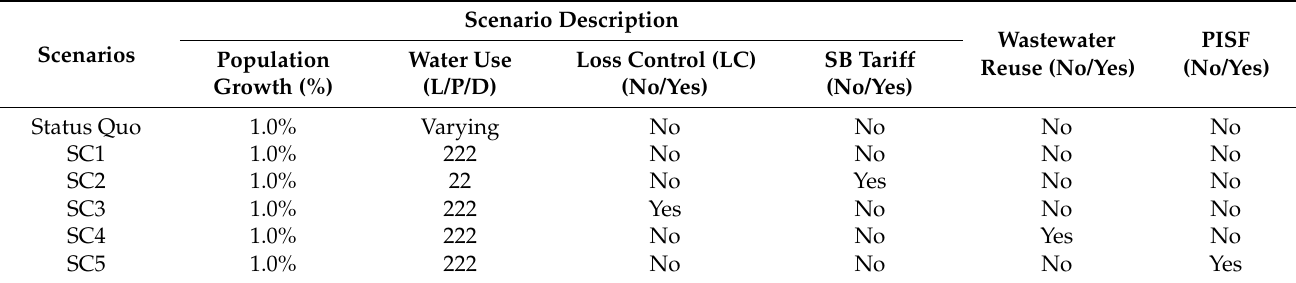
Table 2. Input parameters for the simulation of the